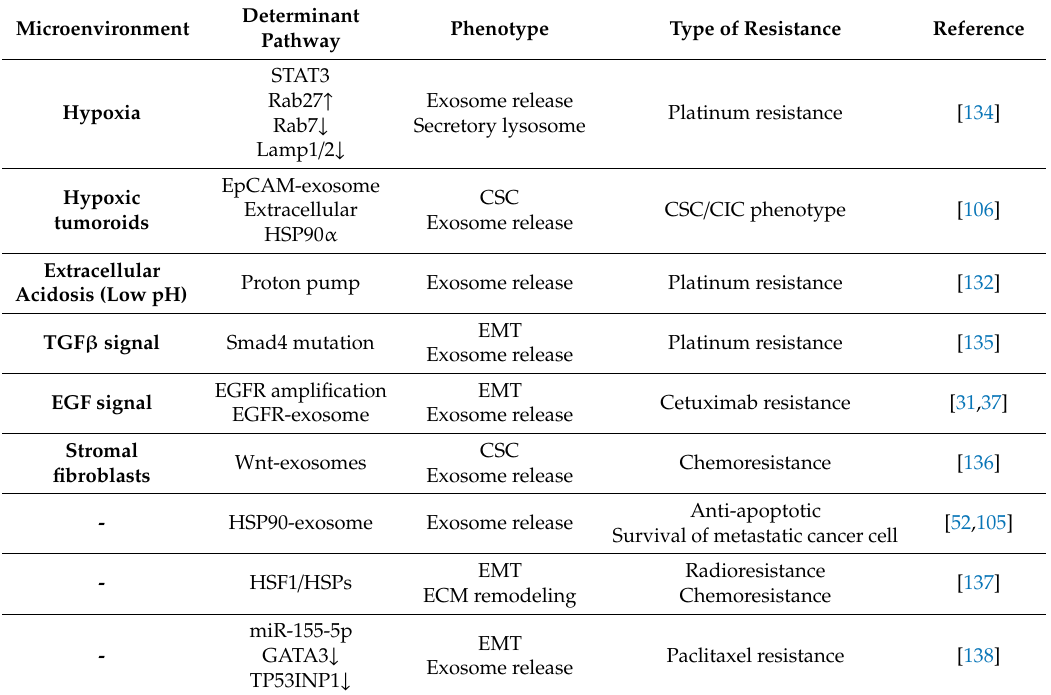
Table 1. Exosomal drug